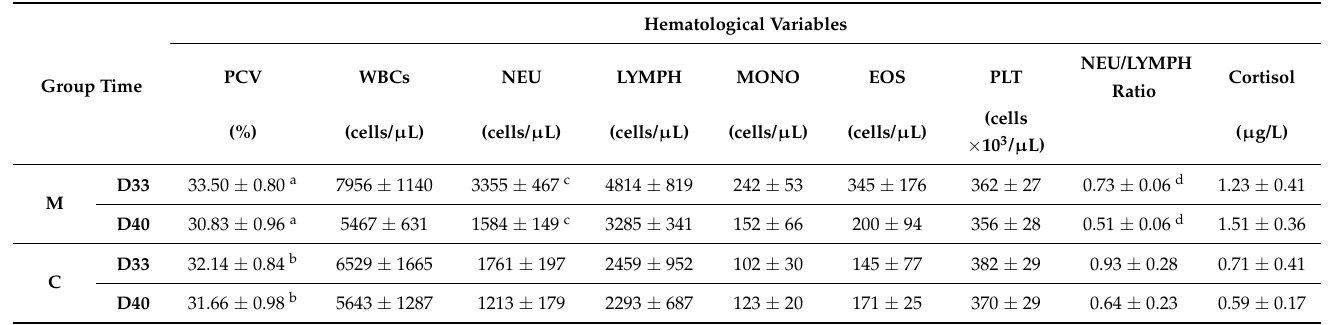
Table 2. Hematological variables and cortisol concentration in blood plasma (mean ± SEM) in group M (melatonin) and group C (control) on D33 and D40.